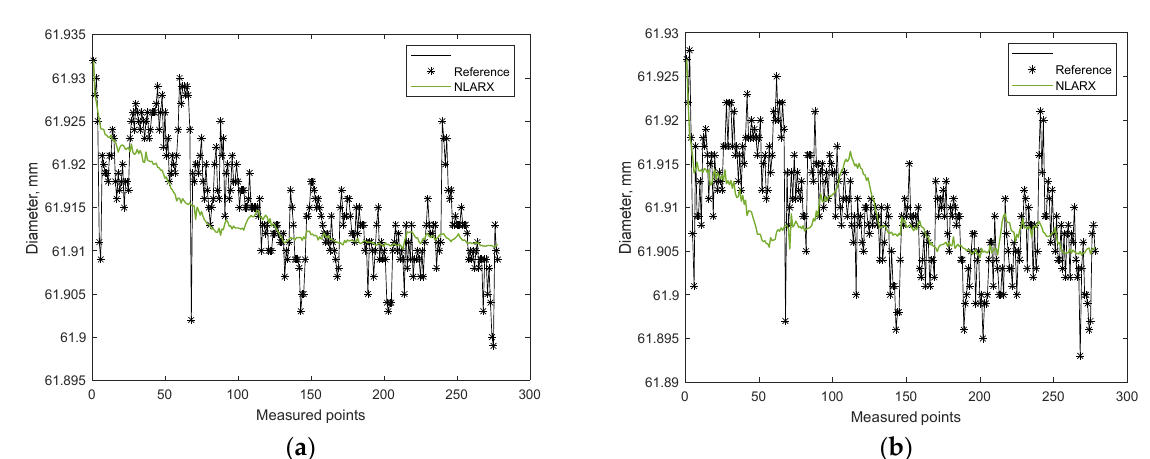
Figure 12. Results of estimation with the use of the NLARX model: ( a ) measurement at point A on the workpiece; ( b ) measurement at point B on the workpiece.